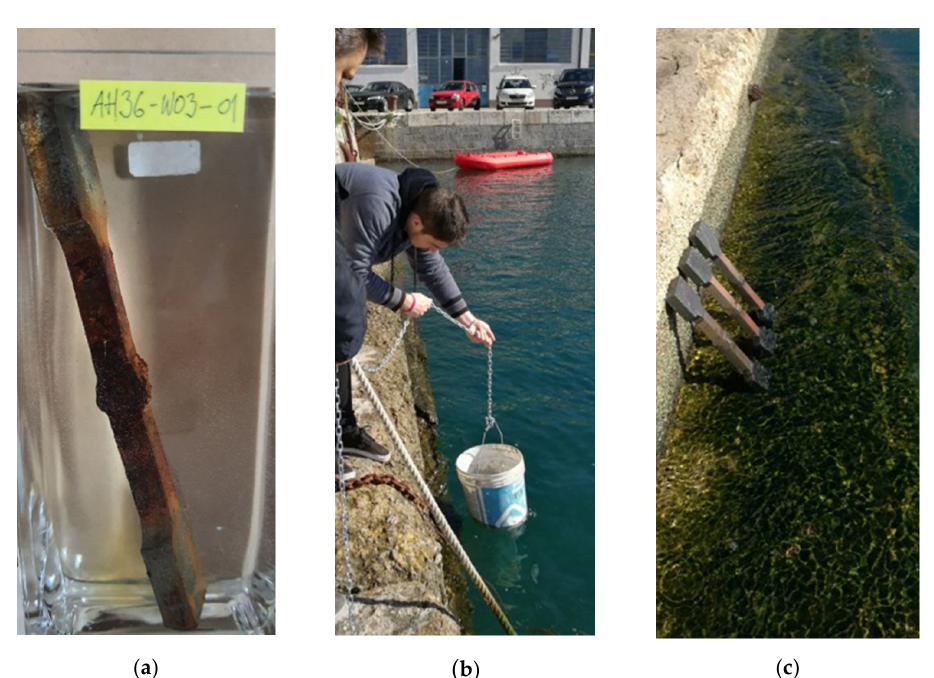
Figure 2. Exposure of specimens to corrosive environment: ( a ) water, ( b ) seawater, ( c ) sea splash. Tap water at room temperature was changed daily to ensure that specimens were in contact with fresh water. Specimens exposed in the sea were affected by changes of sea temperature, salinity, and pH value. At the location of the experiment, sea temperature